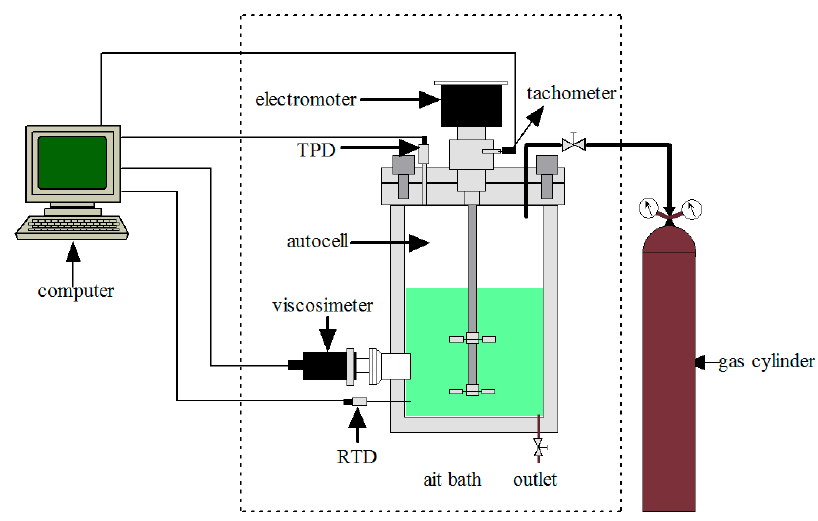
Figure 11. High-pressure hydrate slurry viscometer setup.